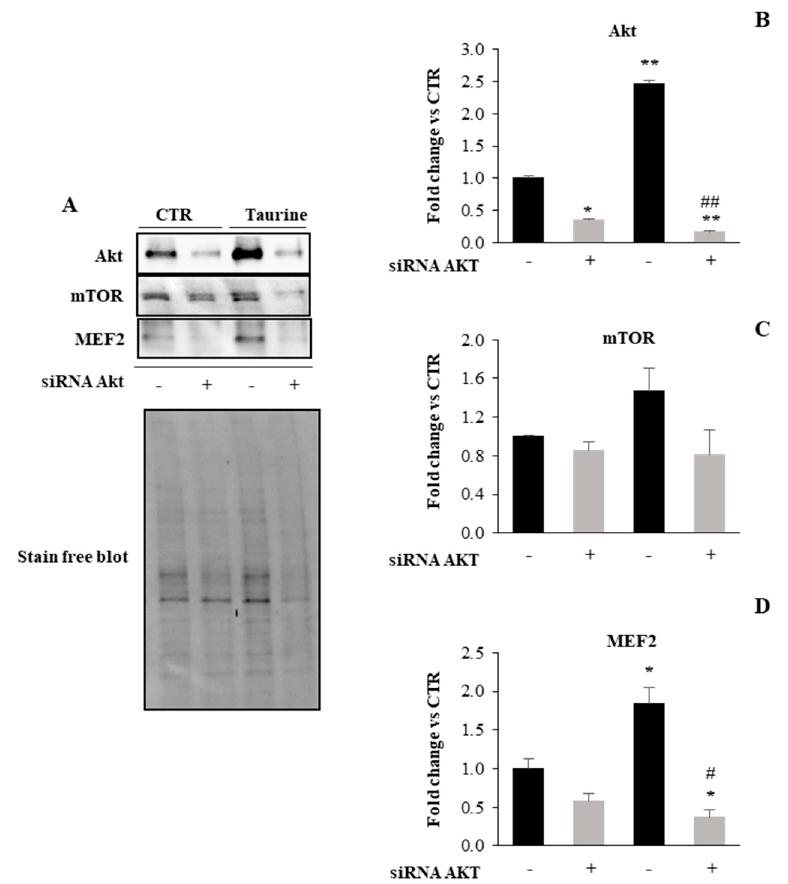
Figure 2. Akt knockdown hampers the effect of taurine on mTOR and MEF2 expression levels. ( A ) Representative Western blots showing Akt, mTOR, and MEF2 protein expression levels in L6 cells extracts treated with taurine and with taurine after silencing of Akt1 gene. ( B – D ) Densitometric analyses were achieved using a Stain-free blot to verify the equal loading of the samples. Graphs show mean ± SD presented as arbitrary units relative to control-vehicle-transfected cells. Statistical analysis was performed using Student’s t-test. *# p < 0.05; **, ## p < 0.01. * Vs. control-vehicle transfected cells; # vs. taurine treated cells.